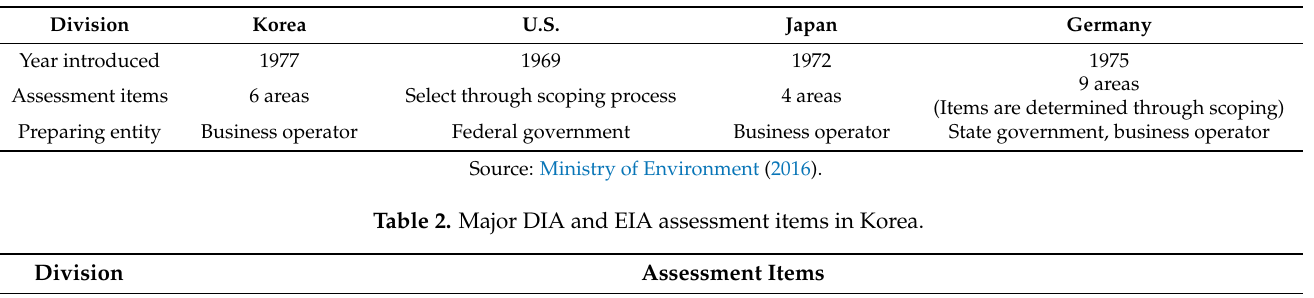
Table 1. Comparison of EIA system by country.